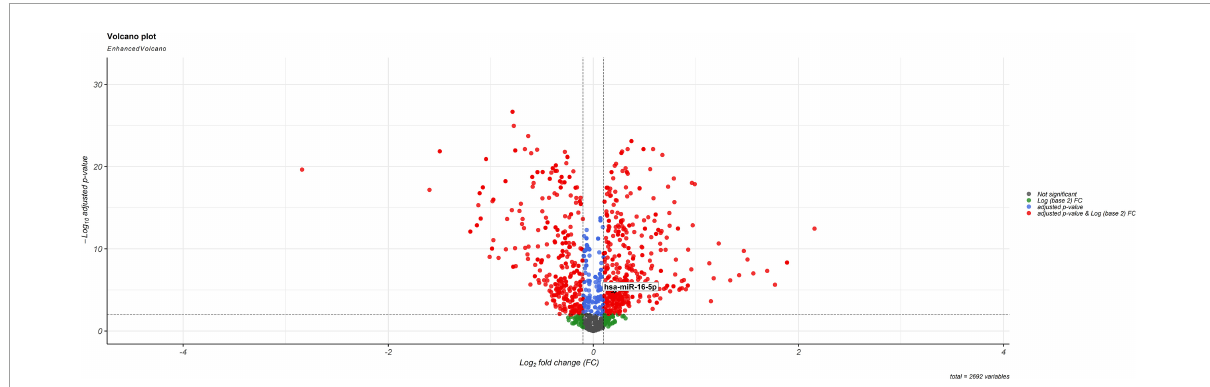
FIGURE3 Volcano plot for the DEmiRs. The DEmiRs were screened based on a | (log 2 FC) | > 0.1 and an adjusted p -value < 0.001.